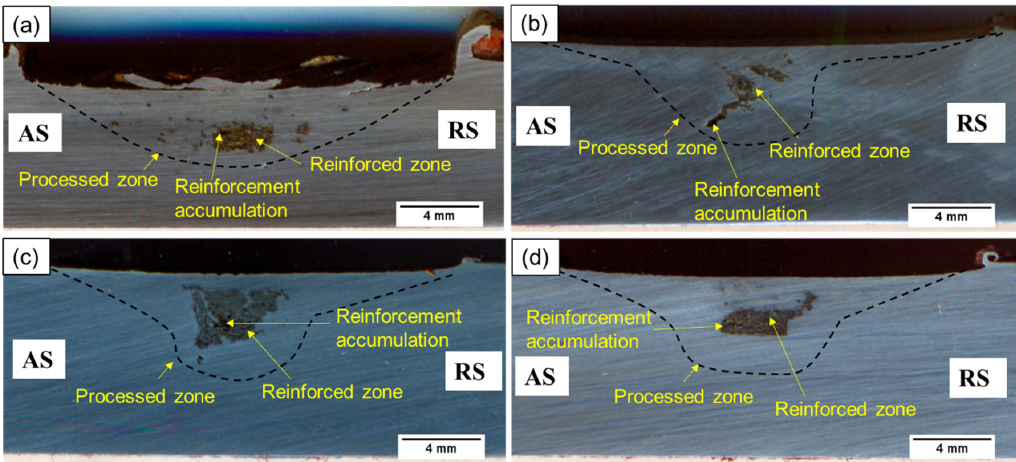
Figure 5. Macro images of the transverse section of processed plates ( a ) specimen 1, ( b ) specimen 2, ( c ) specimen 3, and ( d ) specimen 4.